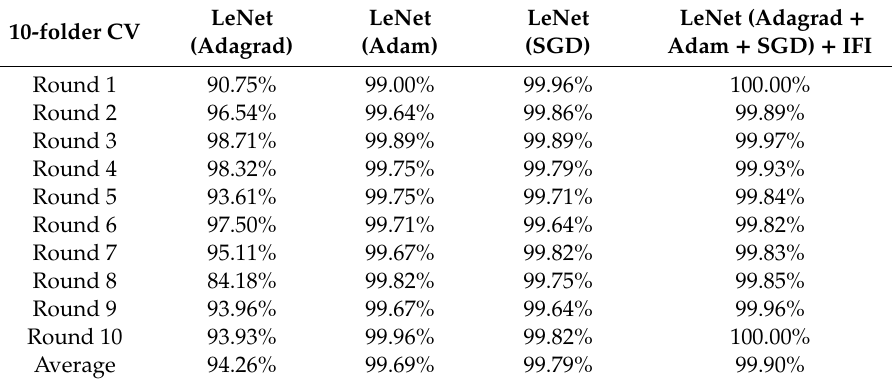
Table 6. Recognition results of LeNet architectures with di ff erent optimization